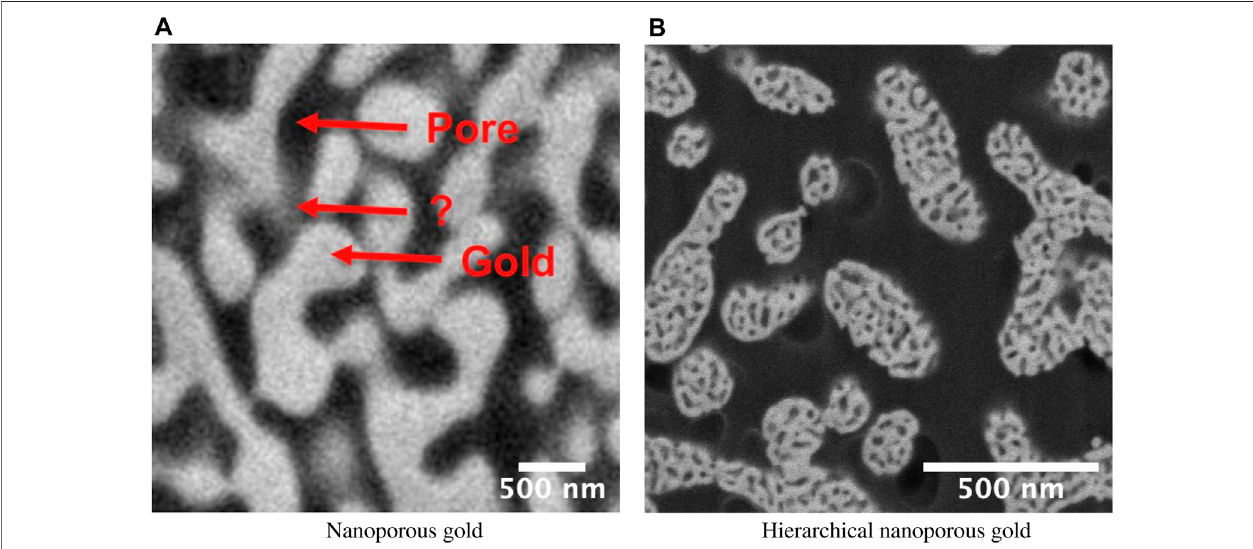
FIGURE 1 | Back-scattered electron scanning microscope images of epoxy-in fi ltrated nanoporous gold (npg) and hierarchical nanoporous gold (hnpg). (A) nanoporousgoldstructuresbelowthecross-sectionplaneshinethroughtheepoxy- fi lledporessothatforsomepixelsitisunclearwhethertheybelongtothesolid(gold) or thepore(epoxy) phase (arrowwith thequestion mark). (B) Thein fl uence oftheshine-through effect isincreasedin hierarchical nanoporous gold due tothesmallpore sizes within the